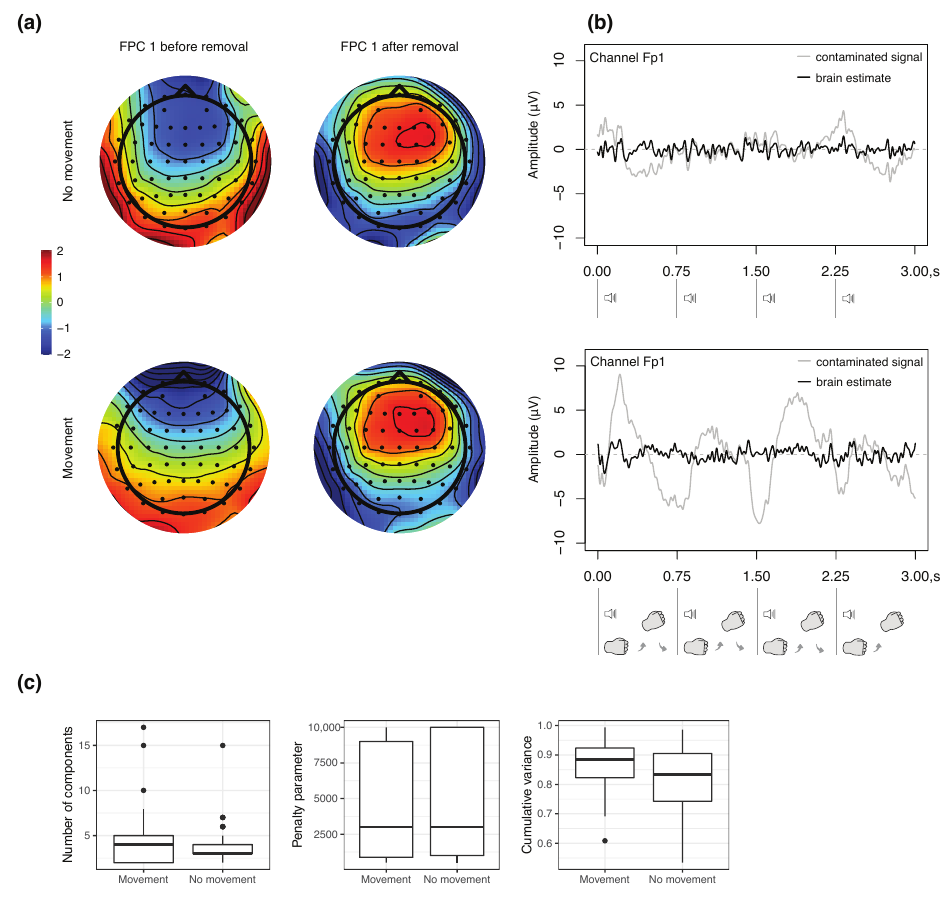
Figure 3. ( a ) Topographic maps representing the leading functional principal component of the averaged trials before performing the P-spline smoothed FICA and after. ( b ) Grand-average across trials of a prefrontal channel where the artifactual activity is revealed. A descriptive scheme of the movement is provided at the bottom of the plots. ( c ) Box plots of the number of components, the selected penality parameter and the cummulative variance of the